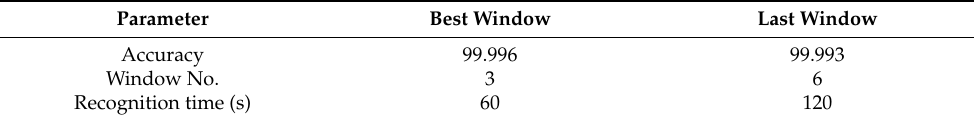
Table 4. Summary of the performance of ANN-C algorithm.